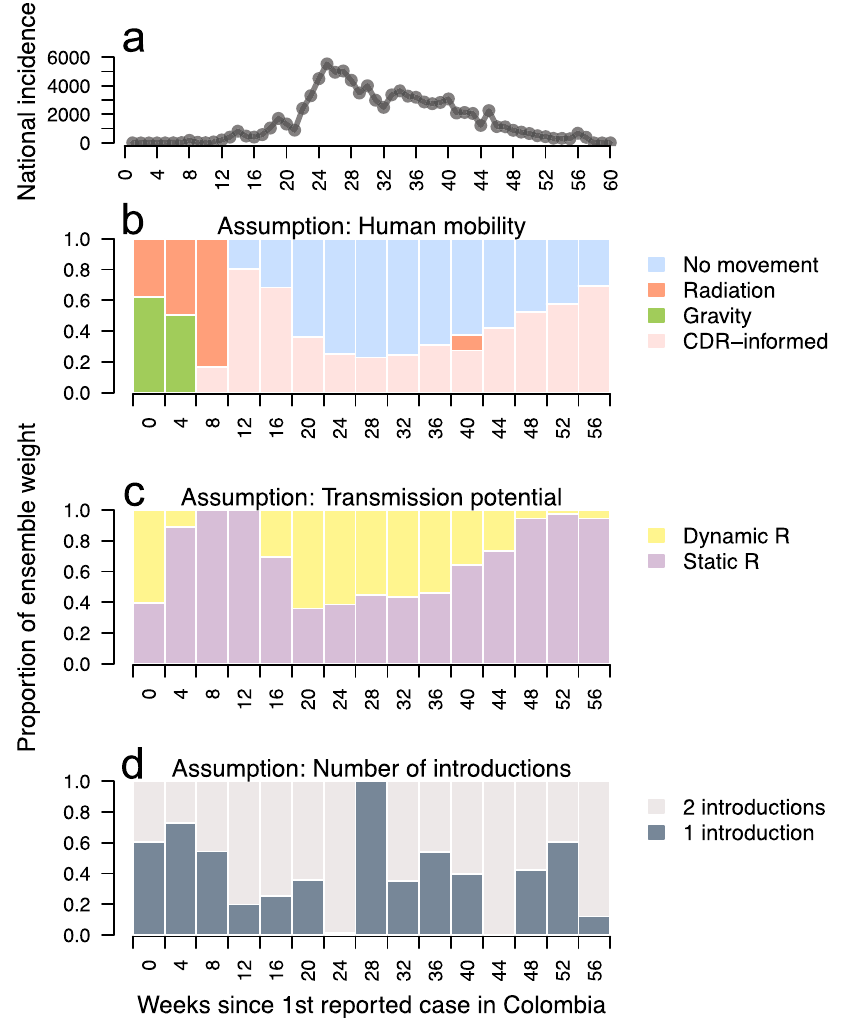
Fig. 3 Ensemble weight partitioned across assumptions about the role of human mobility in driving transmission, drivers of spatiotemporal variation in R , and the number of ZIKV introductions. a Weekly Zika incidence aggregated to the national scale. b – d Proportion of ensemble weight across assumption type colored by explicit